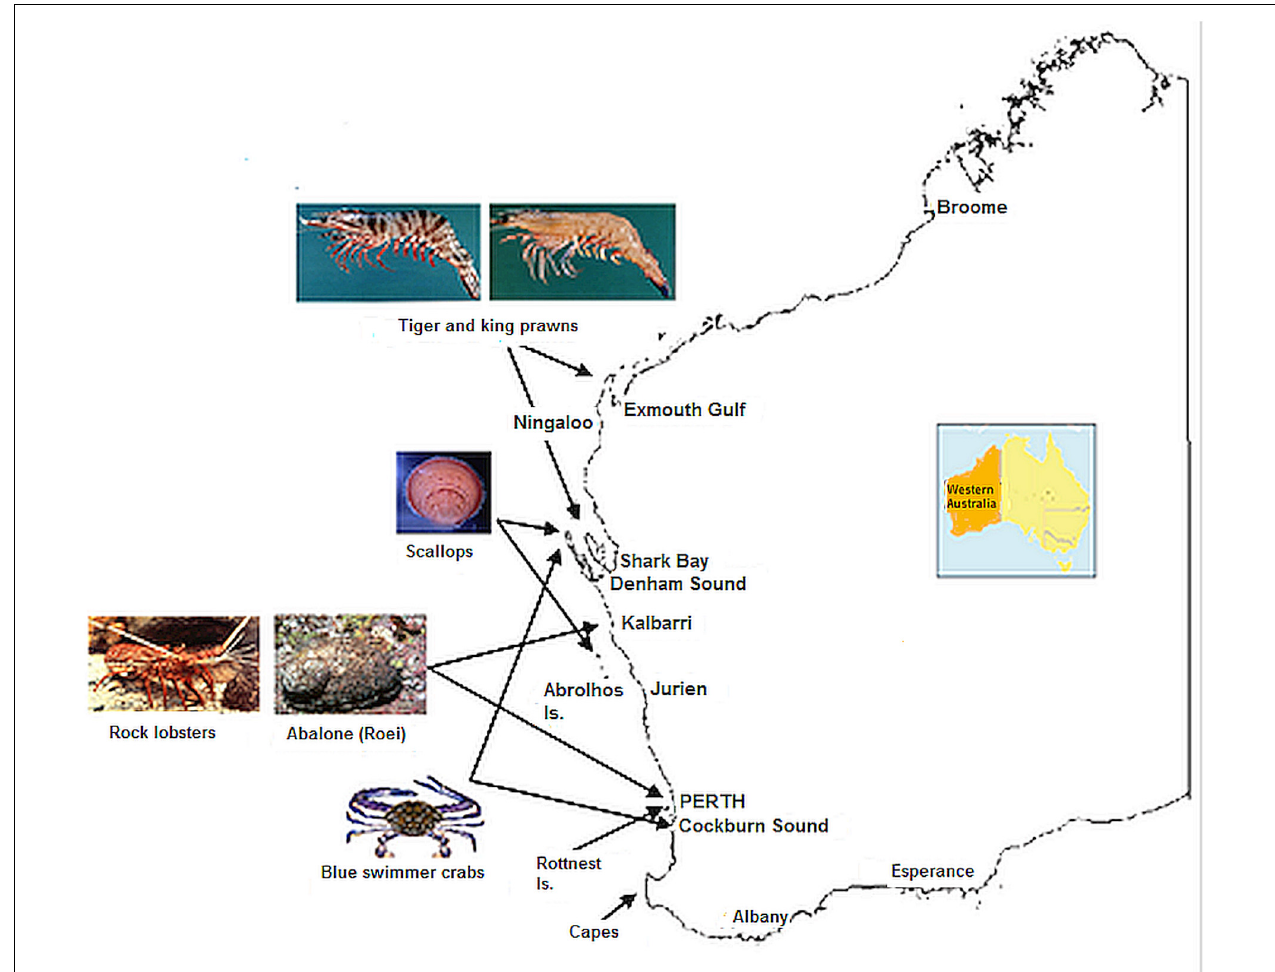
FIGURE 3 | Map of Western Australia showing key locations of fisheries and SST locations specified in Figure 2